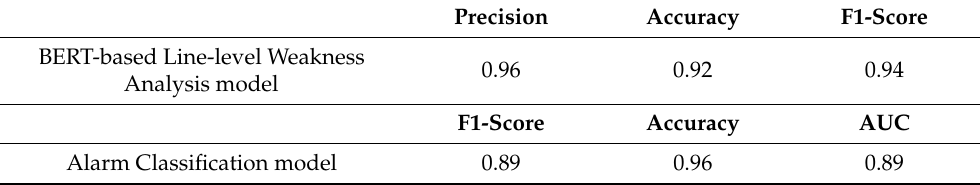
Table 5. Evaluation of BERT-based Line-level Weakness Analysis and Alarm Classification